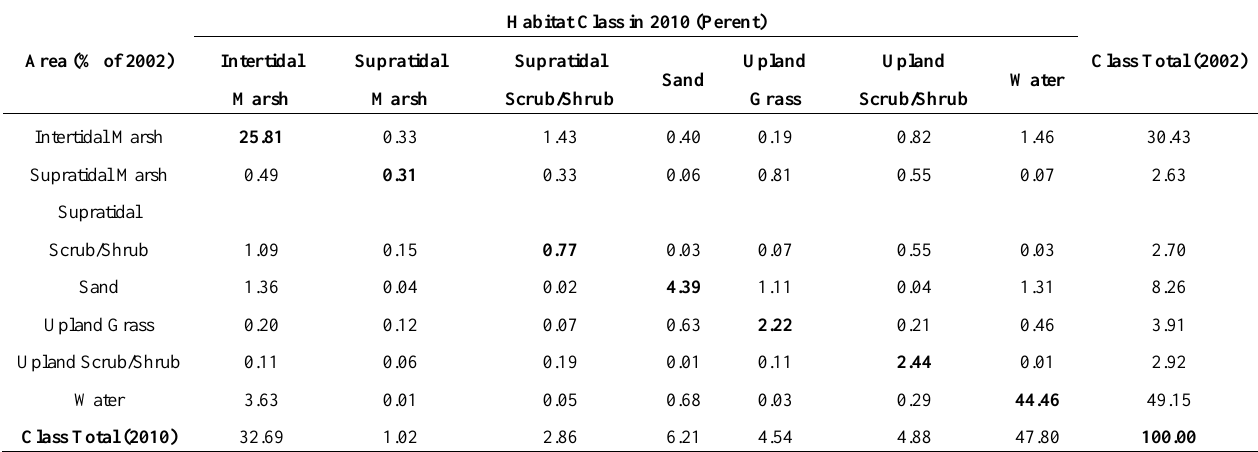
Table 6. Percent change in habitats at NERRS from 2002 to